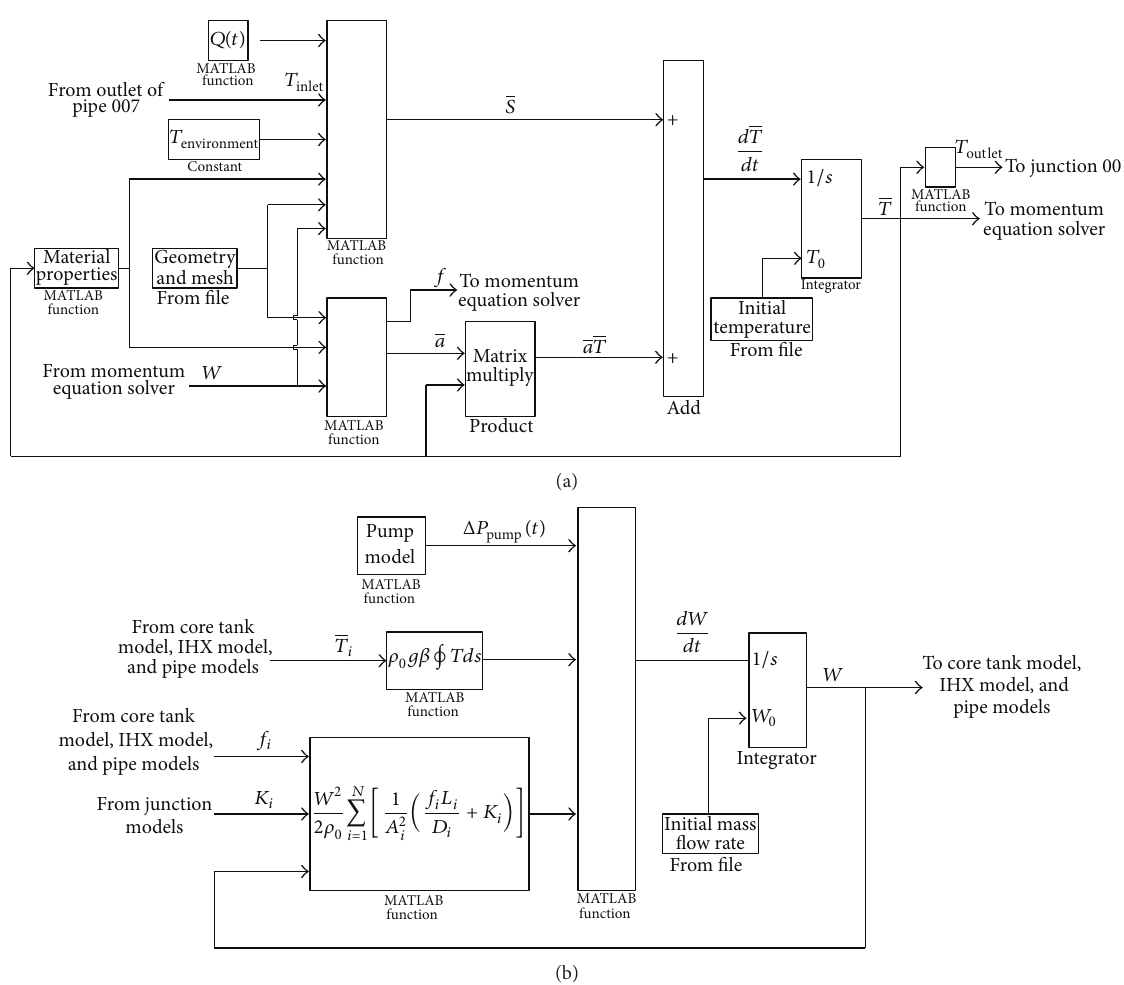
Figure 5: Simulink model for (a) heated part in core tank model and (b) momentum equation solver.